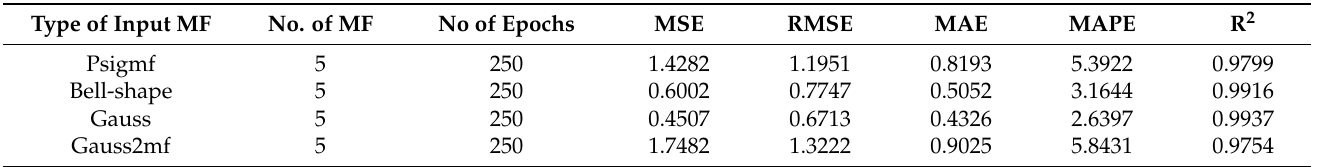
Table 6. Comparative analysis of ANFIS performance for various types of input MFs for constant MF of output.